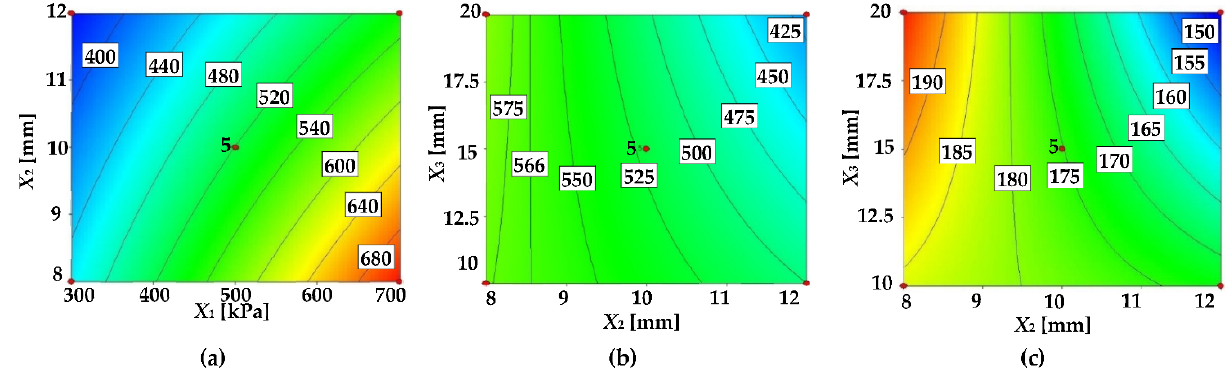
Figure 4. Interaction analysis of significant interactive factor. ( a ) Y 1 = f ( X 1 , X 2 ,0). ( b ) Y 1 = f (0, X 2 , X 3 ). ( c ) Y 2 = f (0, X 2 , X 3 ).